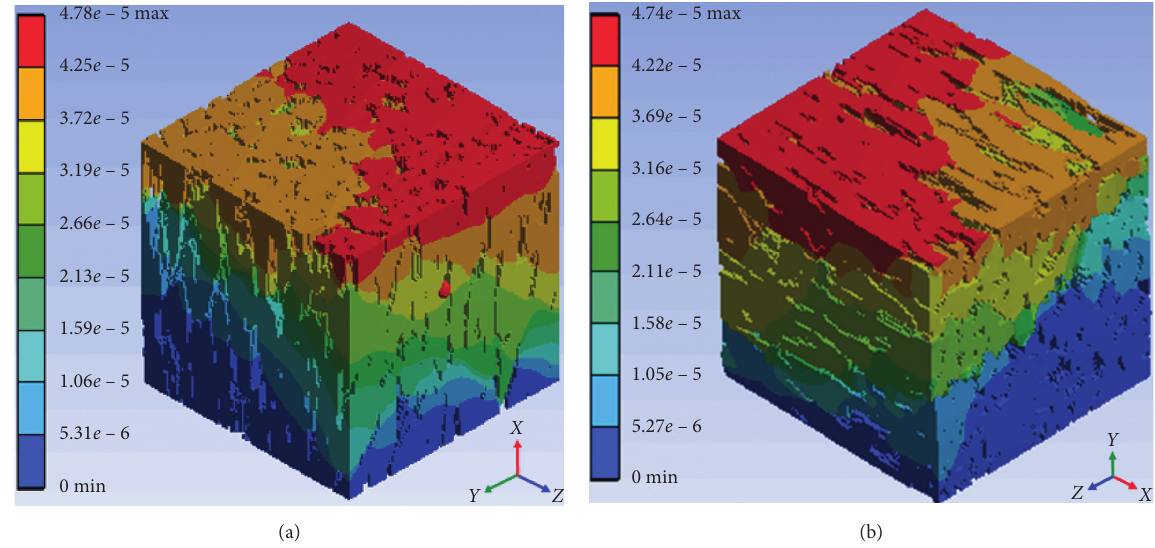
Figure 8: Total displacement distribution of model S2 (unit: m) represents the loading applied (a) in X direction and (b) in Y direction.